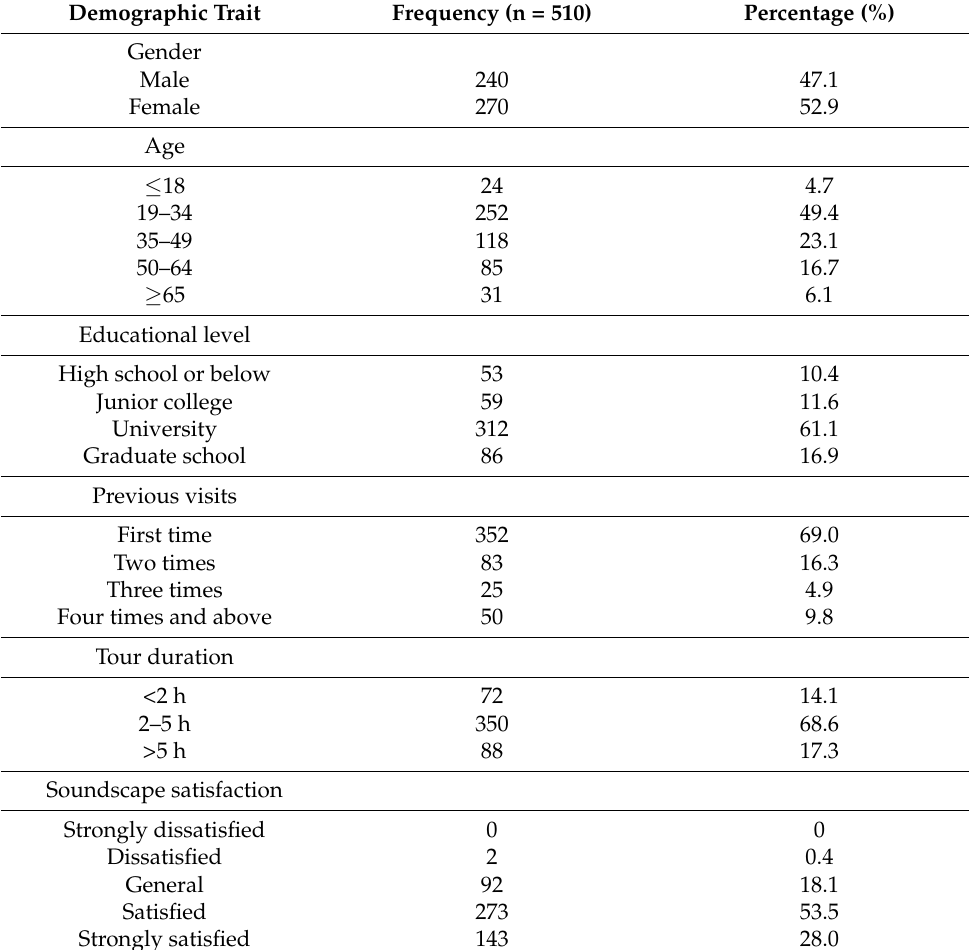
Table 2. Demographic profile of the